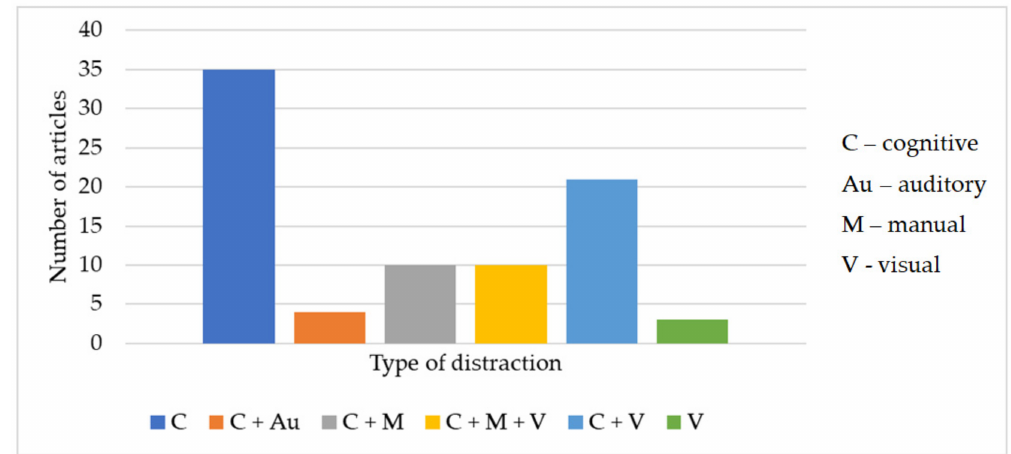
Figure 5. Distribution of papers by the source of distraction